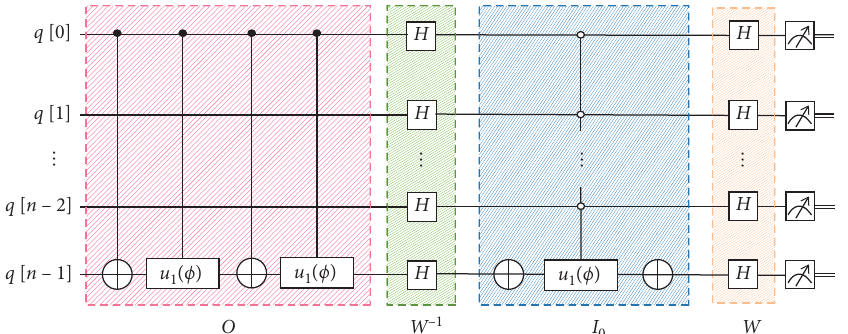
Figure 4: Quantum circuit of amplitude estimation operation; G J represents J iterations of Grover–Long method [35] and F − 1 inverse Fourier transform [36].